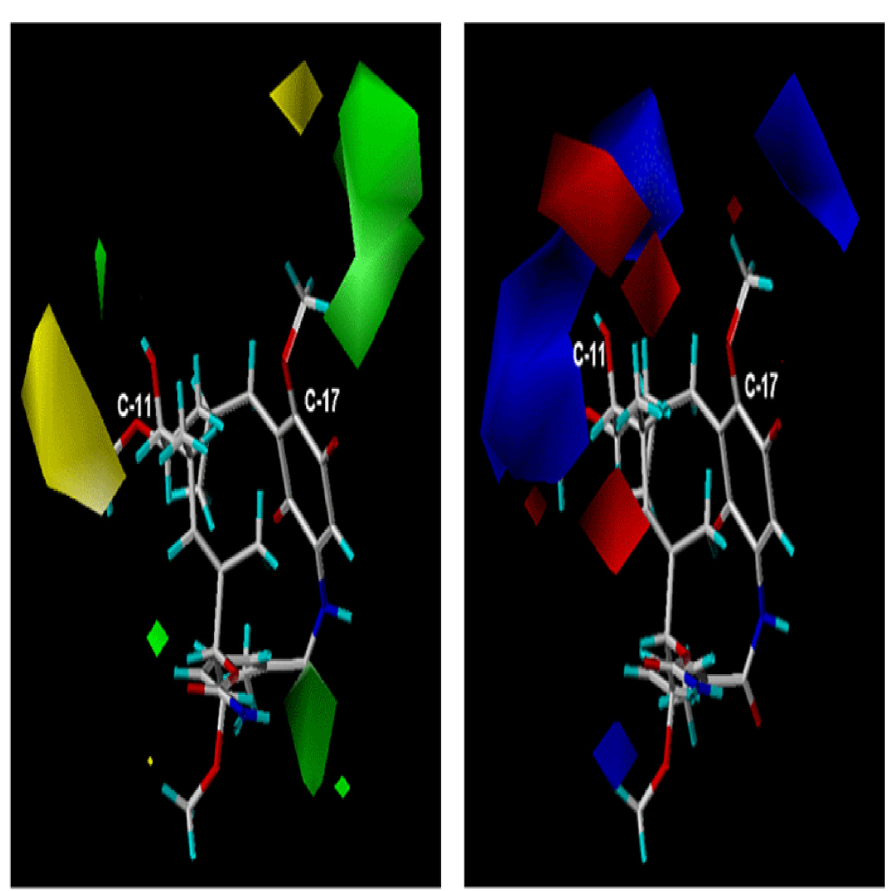
Figure 6. ( a ) Steric map and ( b ) electrostatic map on positions C-11 and C-17 (CoMFA).